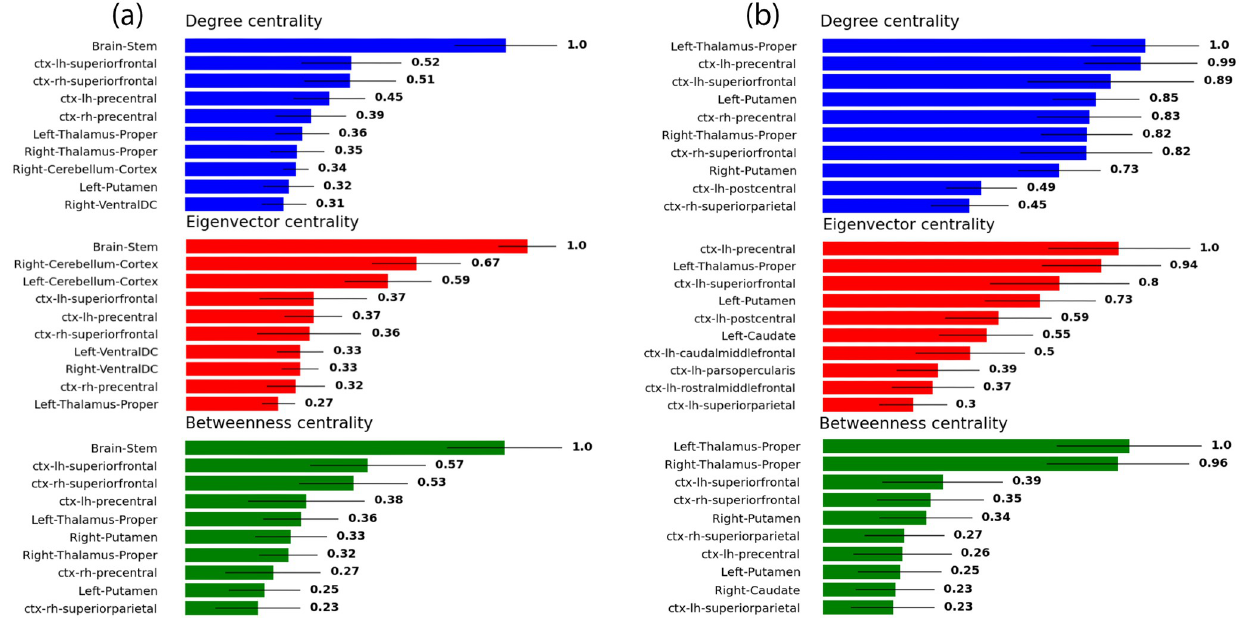
Fig 5. The top 10 central structures for (a) the extended networks and (b) the restricted networks, according to three different measures: Degree centrality (top), eigenvector centrality (middle), and betweenness centrality (bottom). Each of the three quantities is normalized with respect to its own maximum